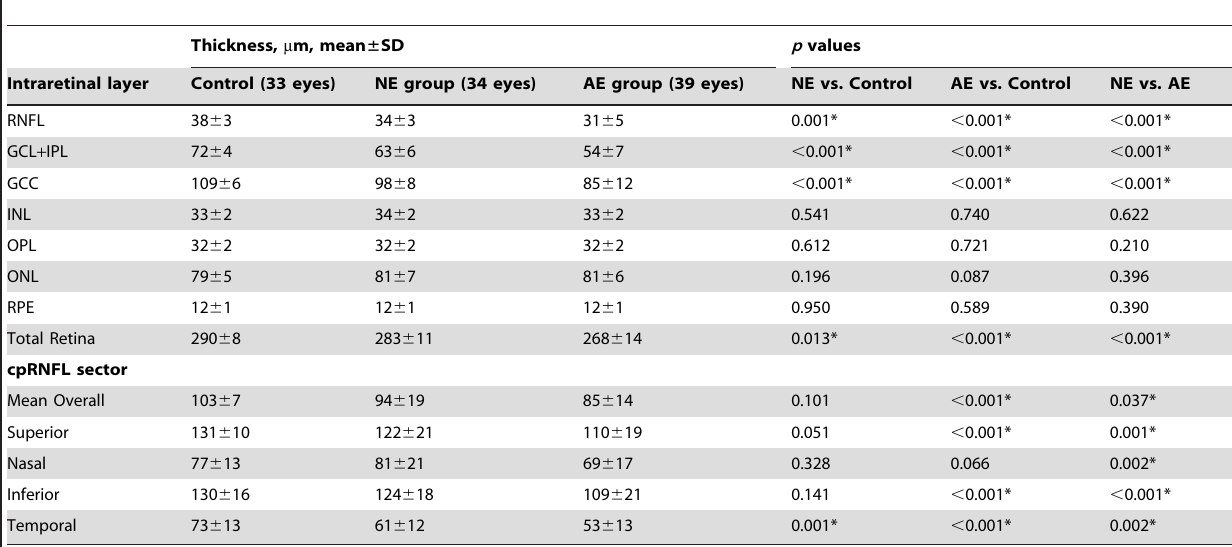
Table 2. WMT values of the intraretinal layers and the total retina in the study